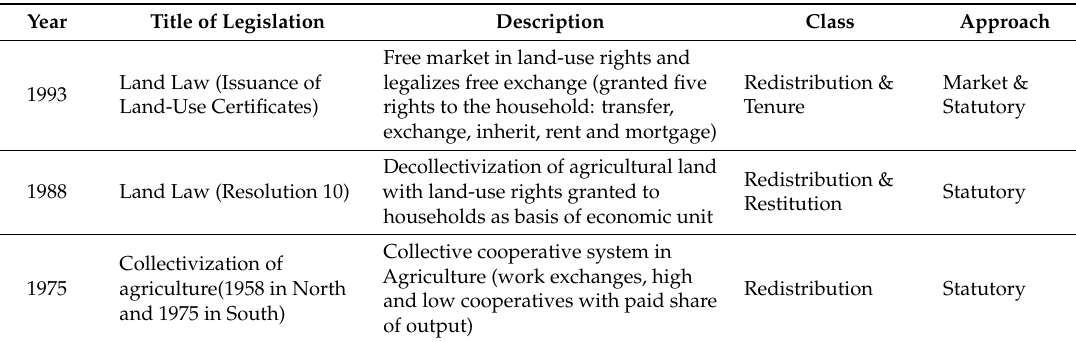
Table 4. Selected pieces of postcolonial land legislation in